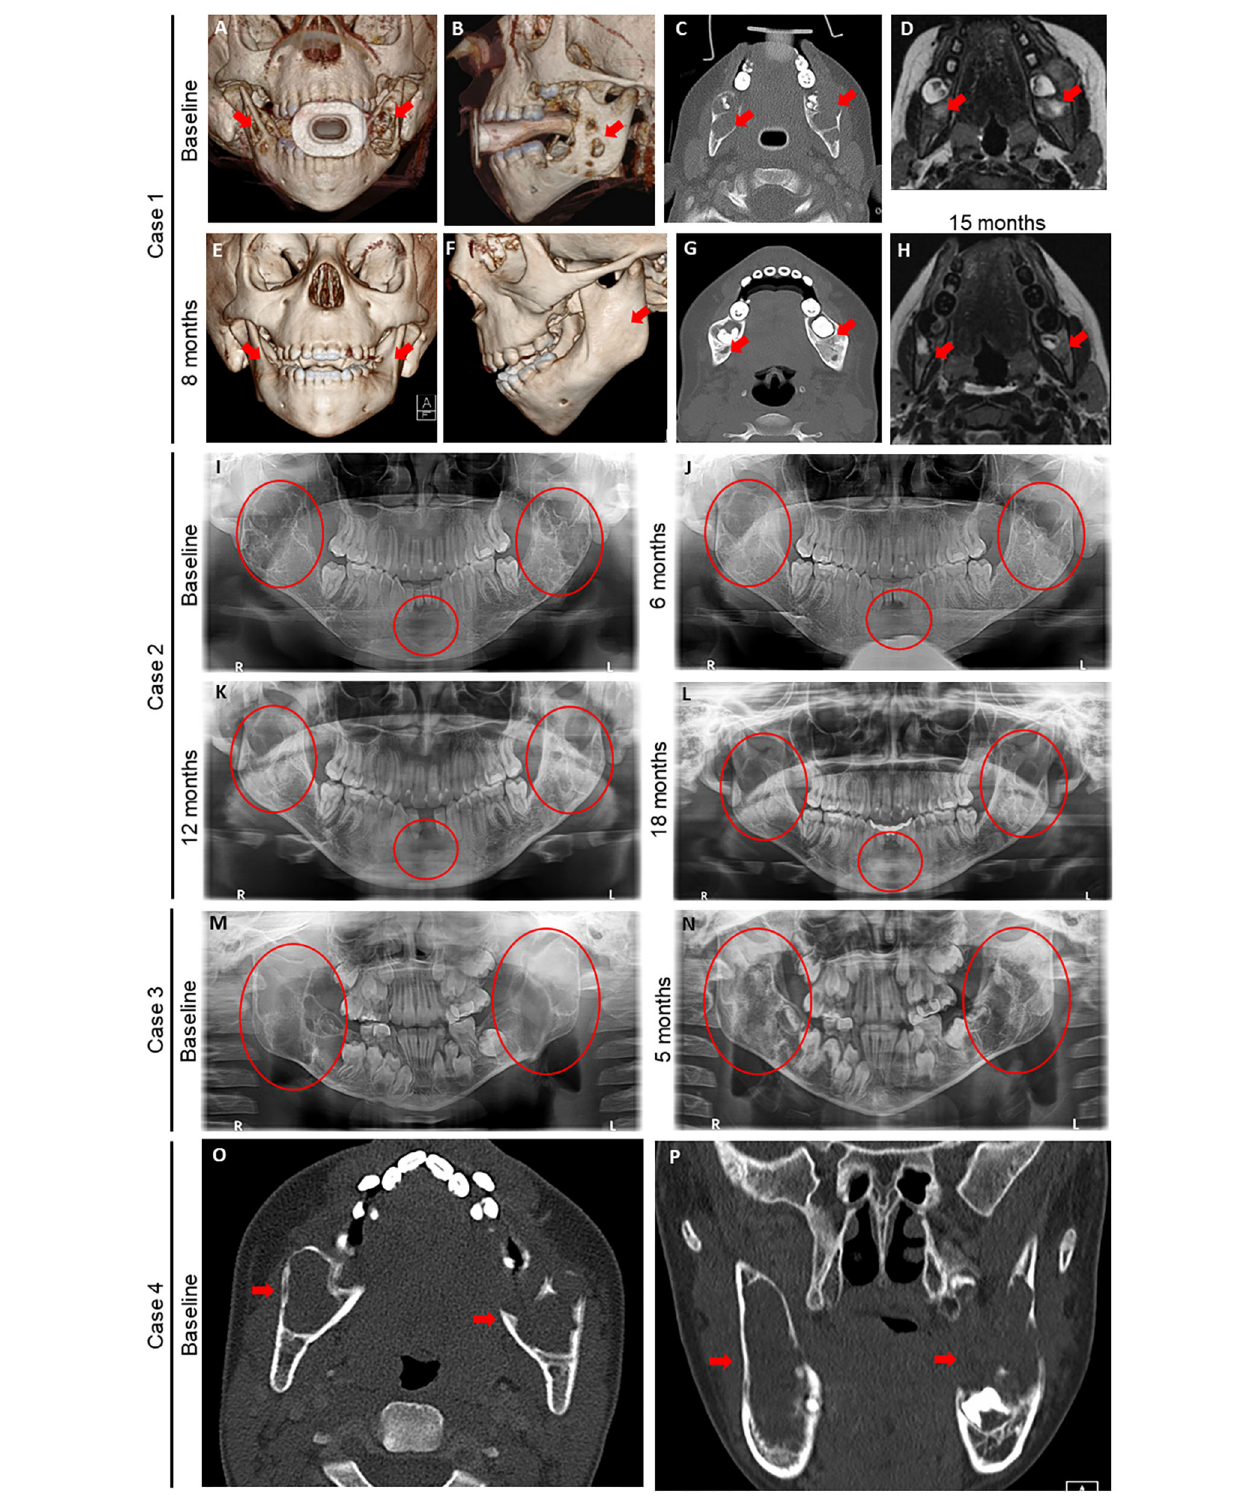
FIGURE 1 | Radiography before and after denosumab in four children with Noonan-like/multiple giant cell lesions (NL/MGCLs). (A–H) Case 1 baseline images (A–D) of 3-dimensional (3D) computed tomography (CT) reconstruction of frontal (A) and profile (B) views, axial CT without contrast (C) , and axial magnetic